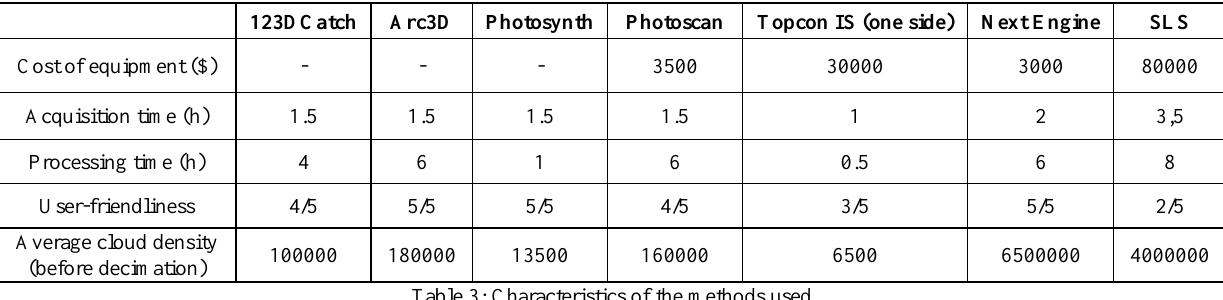
Table 3: Characteristics of the methods